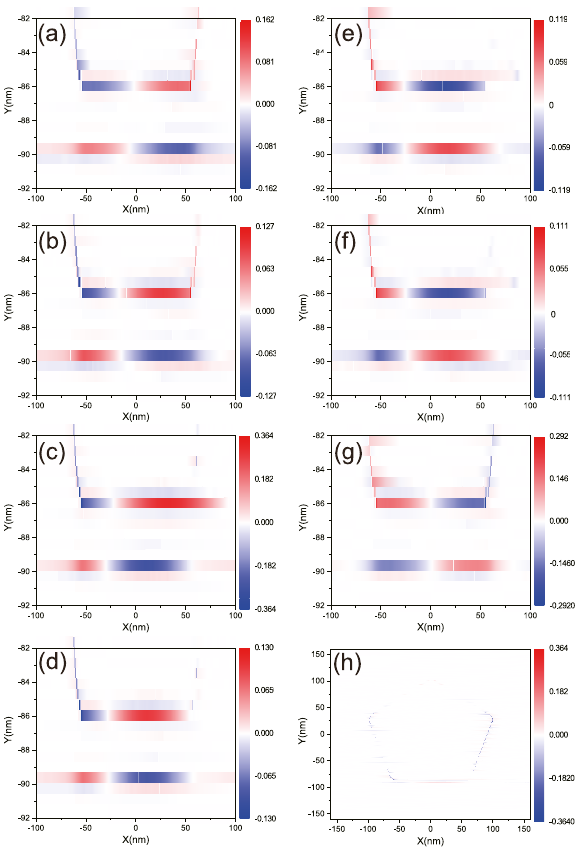
Figure 5: (a – g) The finite-difference time-domain (FDTD) simulation for charge density distribution on xy plane of the surface of section ( z = 0) of the fi lm-coupled NW hybrid gap structure with different incidenceangles θ =0 ° ,15 ° , 30 ° ,45 ° ,60 ° ,75 ° , and90 ° ,respectively. Therangesofthe x- and y -axisare( − 92, − 82nm)and( − 100,100nm), respectively. (h) The case of θ = 30 ° with enlargement ranges of the ranges of the x- and y -axis are from − 200 to 200 nm,